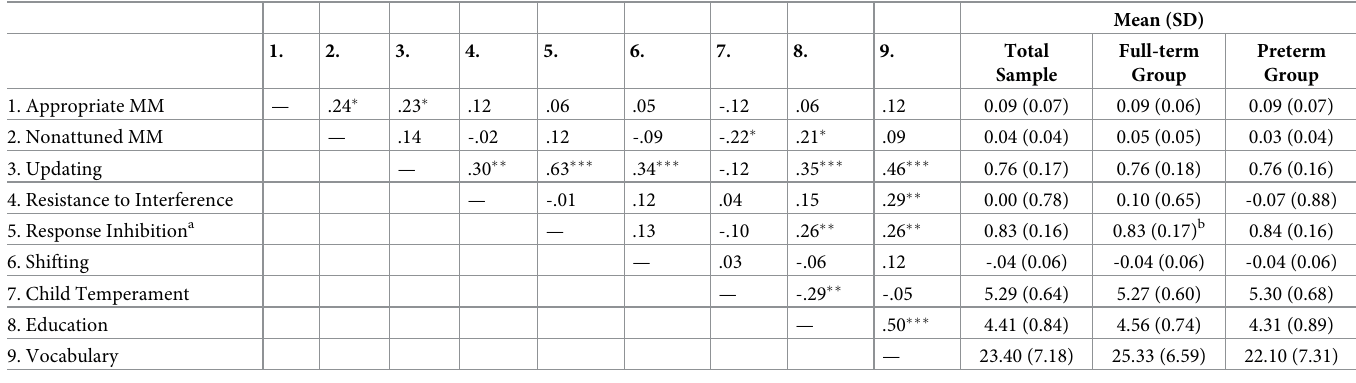
Table 2. Means, standard deviation, and bivariate correlations between study